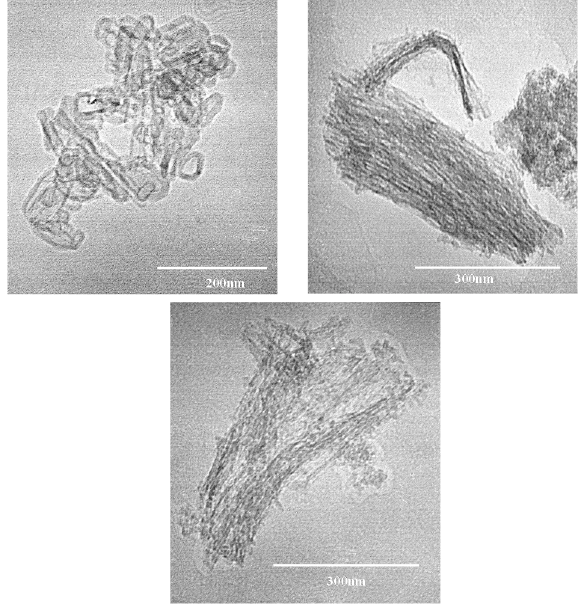
Figure 5. Selected transmission electron microscopy (TEM) micrographs of the TNT sample.